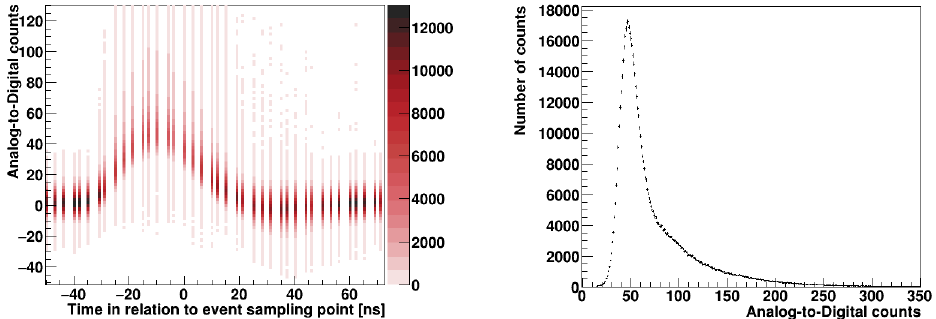
Figure 7. Pulse shape reconstructed with the Landau–Gauss distributions of the charge at each sampling point ( left ) and one selected distribution for the peak of the pulse ( right